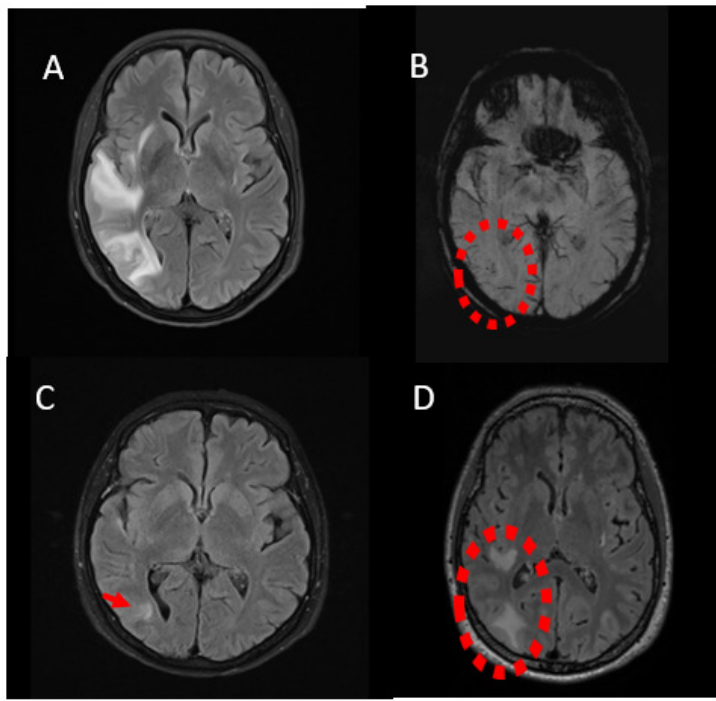
Figure 2. Imaging findings of case 1. Axial fluid-attenuated inversion recovery (FLAIR) sequence demonstrating white-matter hyperintensities right temporoparietal ( A ); Low-signal spots in axial SWI (( B ); dotted circle). Follow-up MRI one month later with substantial resolution of the white matter hyperintensities in axial FLAIR sequence (( C ); arrow); Recurrence of white-matter hyperintensities on axial FLAIR image two years later (( D ); dotted